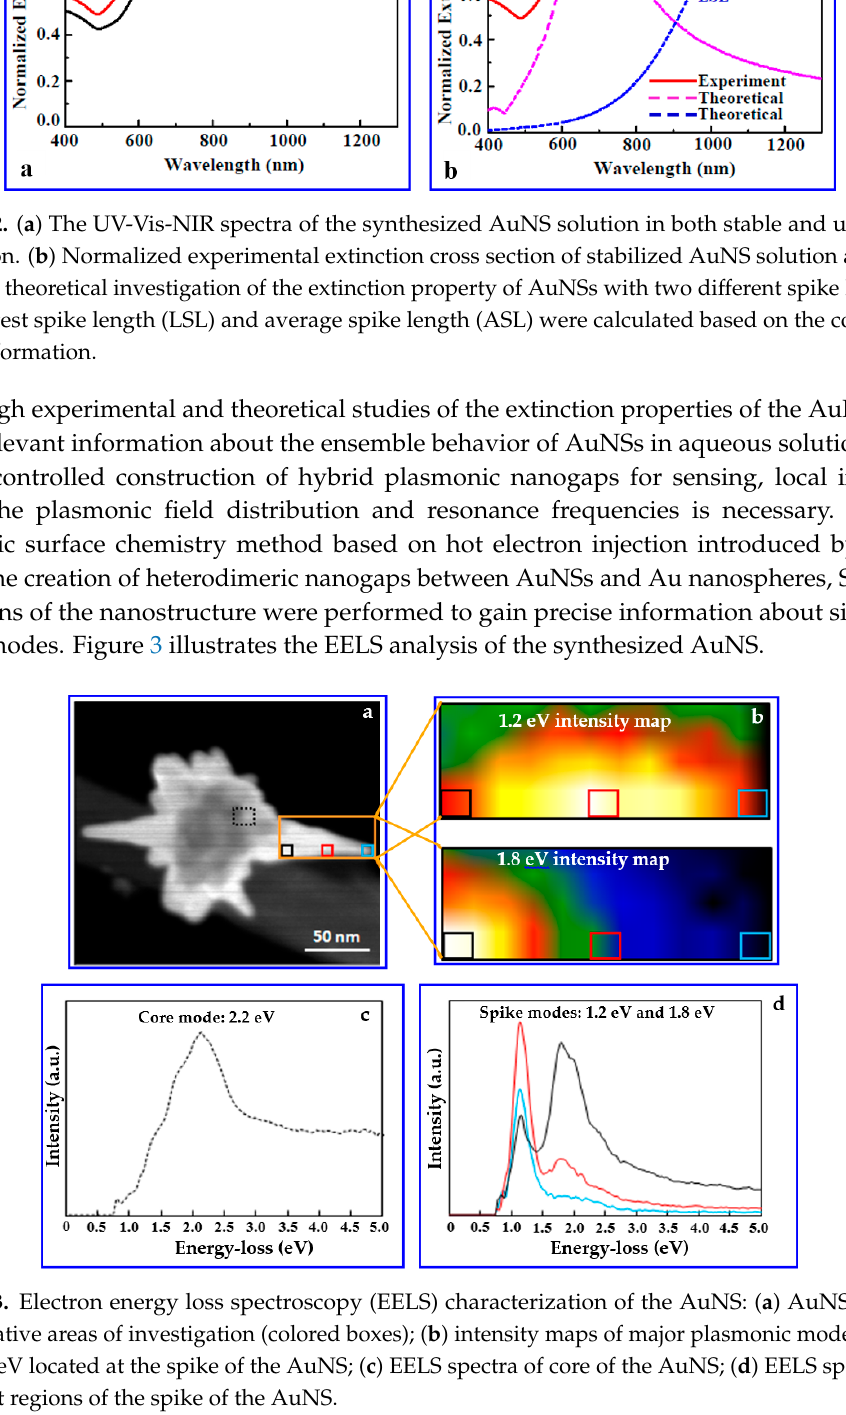
Figure 3. Electron energy loss spectroscopy (EELS) characterization of the AuNS: ( a ) AuNS image with relative areas of investigation (colored boxes); ( b ) intensity maps of major plasmonic modes at 1.2 and 1.8 eV located at the spike of the AuNS; ( c ) EELS spectra of core of the AuNS; ( d ) EELS spectra of different regions of the spike of the AuNS.